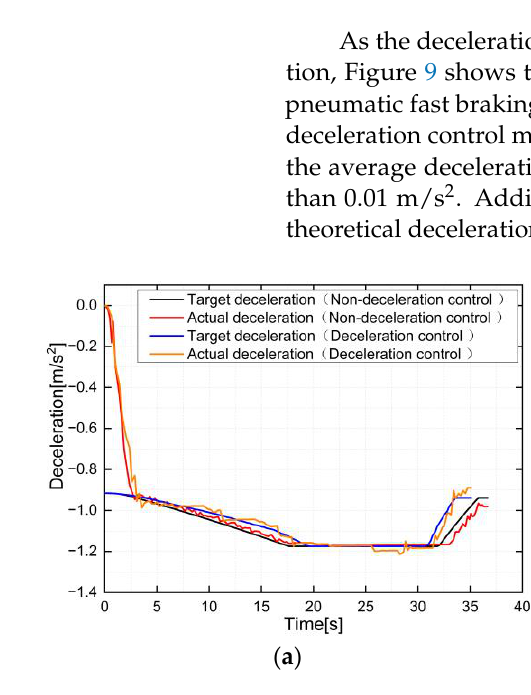
Figure 9. Test results without uncertain parameters: ( a ) pure pneumatic full-service braking; ( b ) electro-pneumatic fast braking. Table 2. Test results of Figure 9.